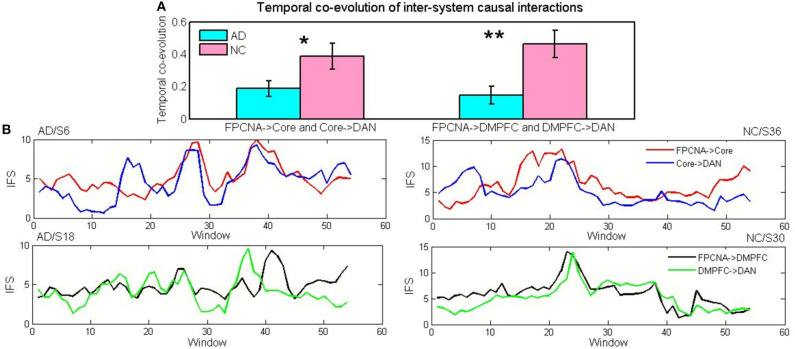
Temporal co-evolution of inter-system causal interactions in the NC and AD groups. (A) Temporal co-evolution between FPCNA->Core IFS and Core->DAN IFS and between FPCNA->DM IFS and DM->DAN IFS in the NC and AD groups (*p < 0.05, **p < 0.005). Error bars represent the standard error of the mean. (B) Data for four randomly chosen example participants demonstrating IFS from FPCNA to Core and IFS from Core to DAN (Top) as well as IFS from FPCNA to DM and IFS from DM to DAN (Bottom) within successive 60-second windows in the AD and NC groups.